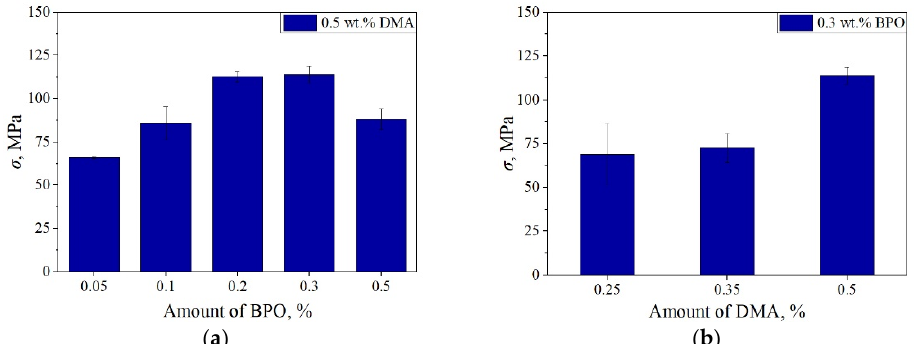
Figure 5. Maximum compressive strength of bone cement with ( a ) 0.5 wt.% of DMA and different amounts of the BPO initiator, and ( b ) 0.3 wt.% of BPO and various concentrations of the DMA co-initiator.